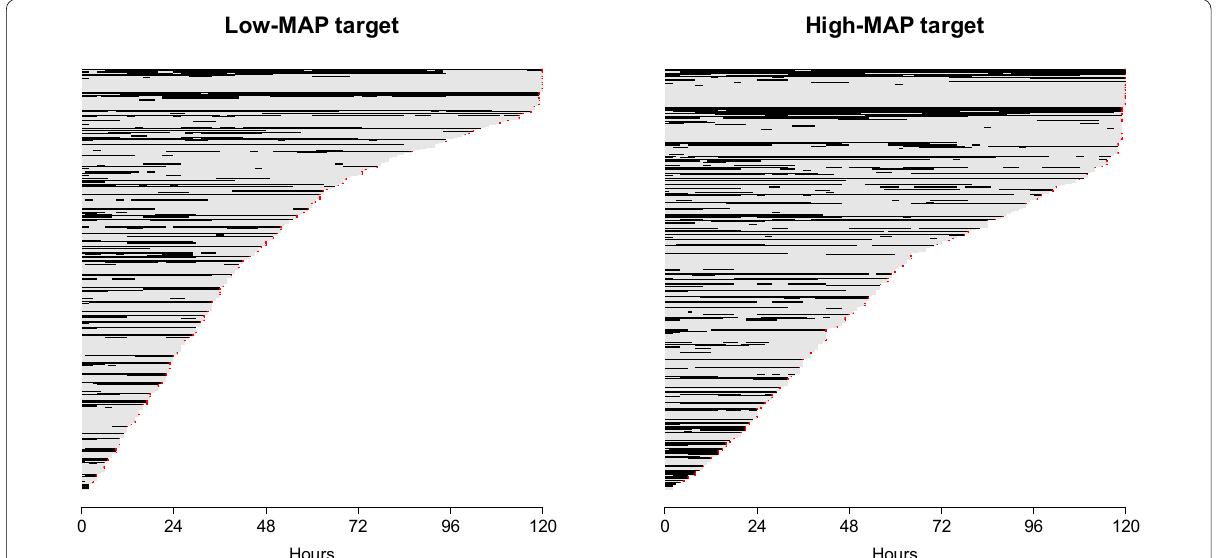
Fig. 1 Course of mottling in patients with septic shock, according to the mean arterial pressure (MAP) target. Low‑MAP target group: 65–70 mmHg, high‑MAP target group: 80–85 mmHg. Each horizontal line represents a patient follow‑up. The length of the line represents the length of observation time of the patient. Black line corresponds to a period of time with mottling; and grey line corresponds to a period of time without mottling for the patient. There was no difference in mottling time course according to the MAP target. A red asterisk at the end of a line represents the death of the patient